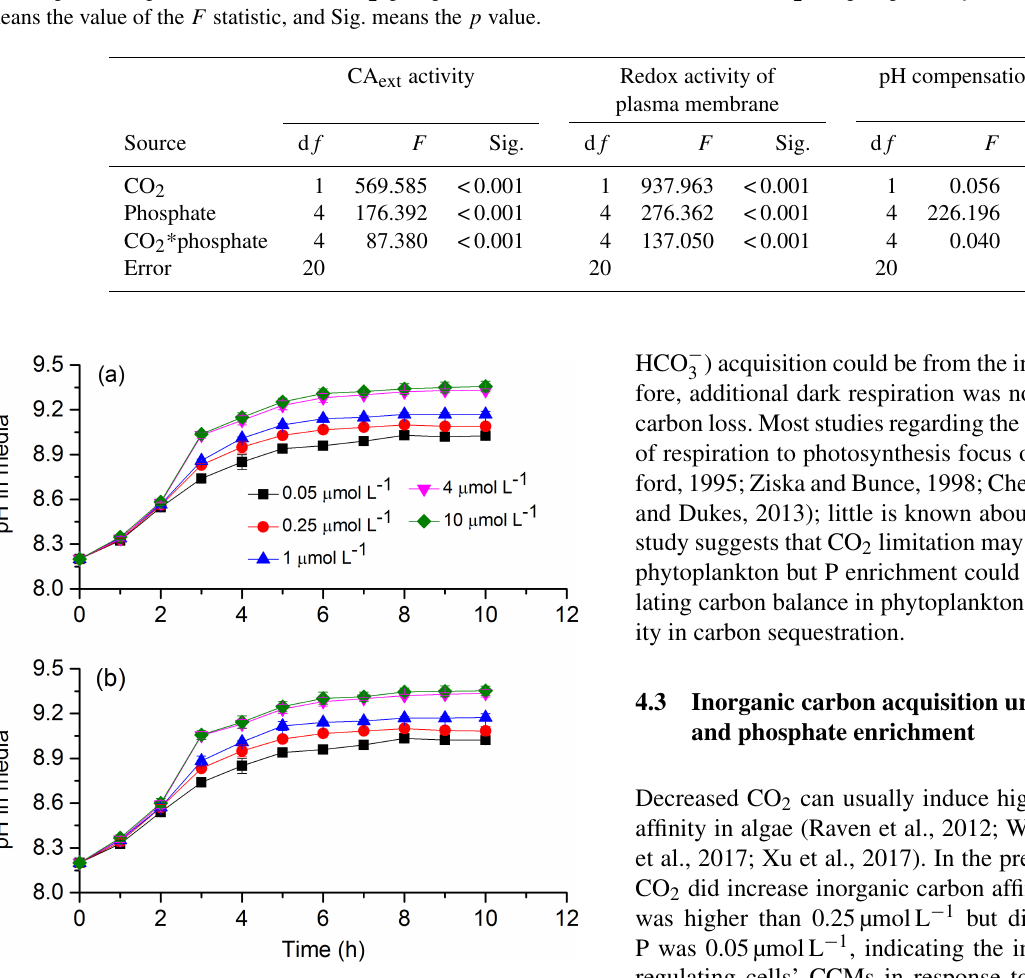
Figure 7. Changes of pH in a closed system caused by photosynthe- sis of S. costatum grown at various phosphate concentrations after 12.6 and 2.8µmol CO 2 treatments. The error bars indicate the stan- dard deviations ( n =